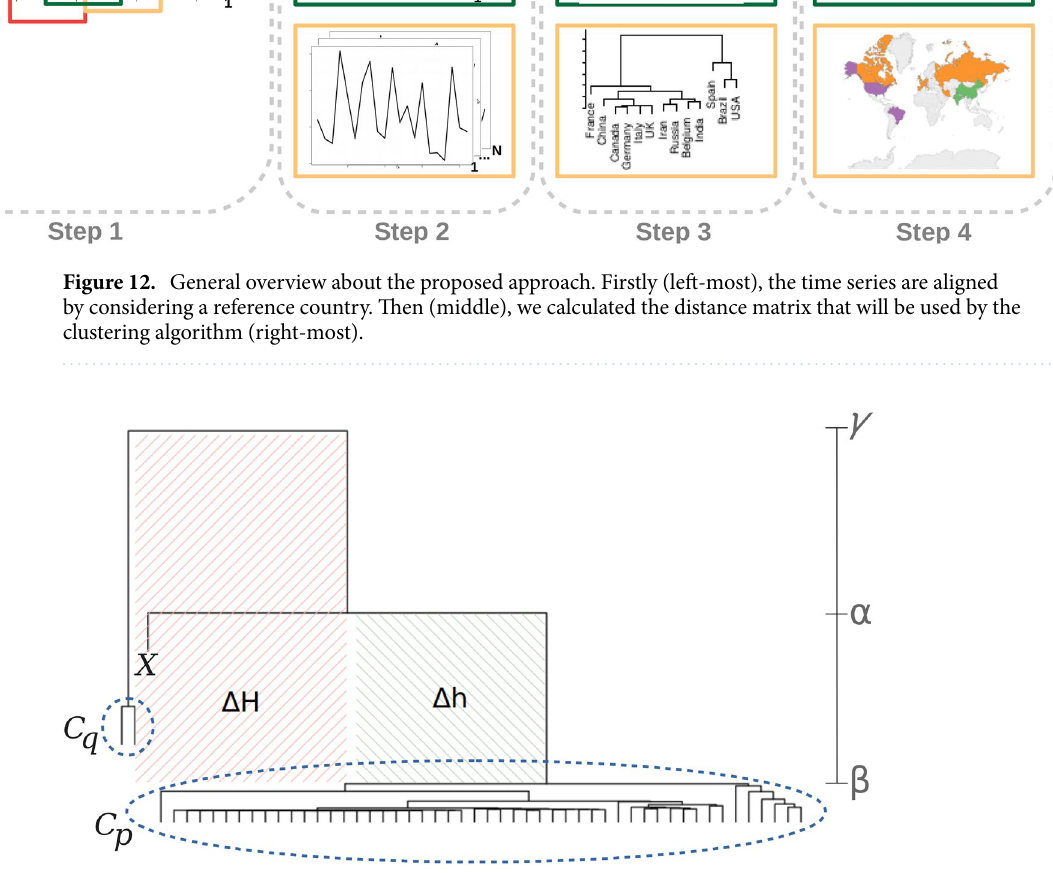
Figure 13. Visual interpretation of T X . In this illustration, the transition index of a country X calculates the distance from its current cluster C p to its closest one C q . For example, if this ratio increases in the next time window, the chance of moving X to C q is greater. The dendrogram clades α , β , and γ are used to calculate T X . This figure was generated by using the software Inkscape 1.0.2 available at https:// www. inksc ape.